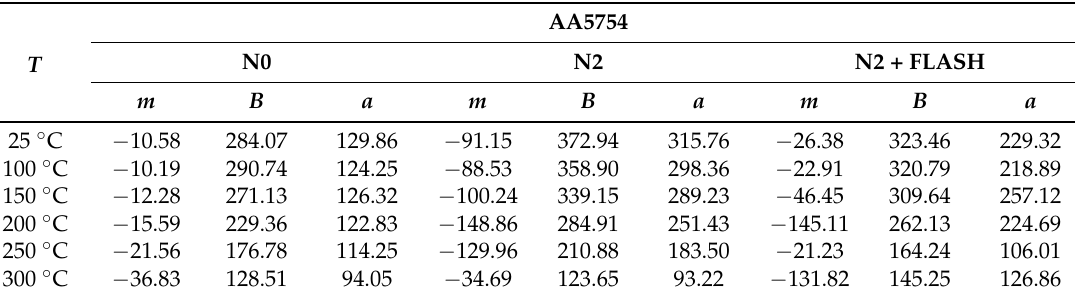
Table 9. Values for Voce’s parameters in the case of AA5754.